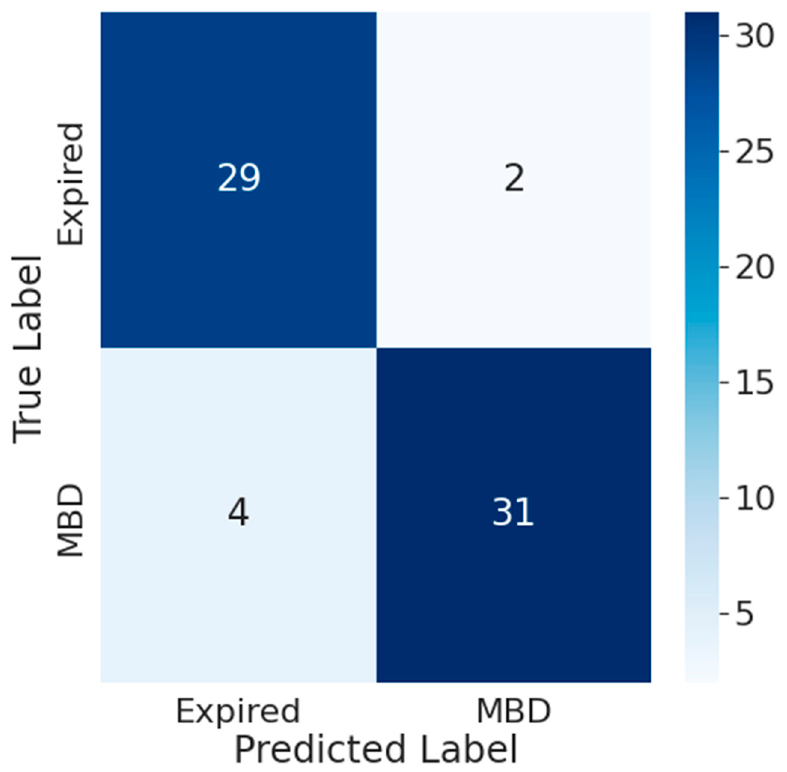
Figure A16. LSTM model confusion matrix using the clinical and wearable data.